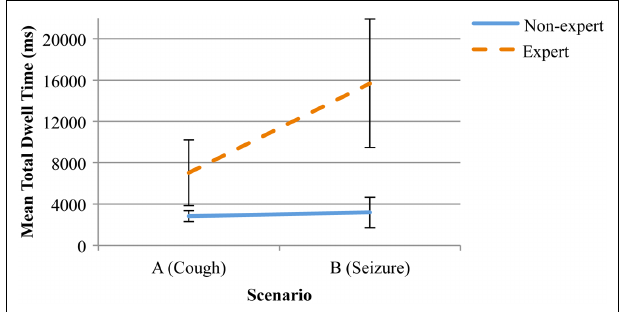
FIGURE 3 | Mean total dwell time (ms) and standard error on the “head and face” for experts and competent non-experts, distributed across the two